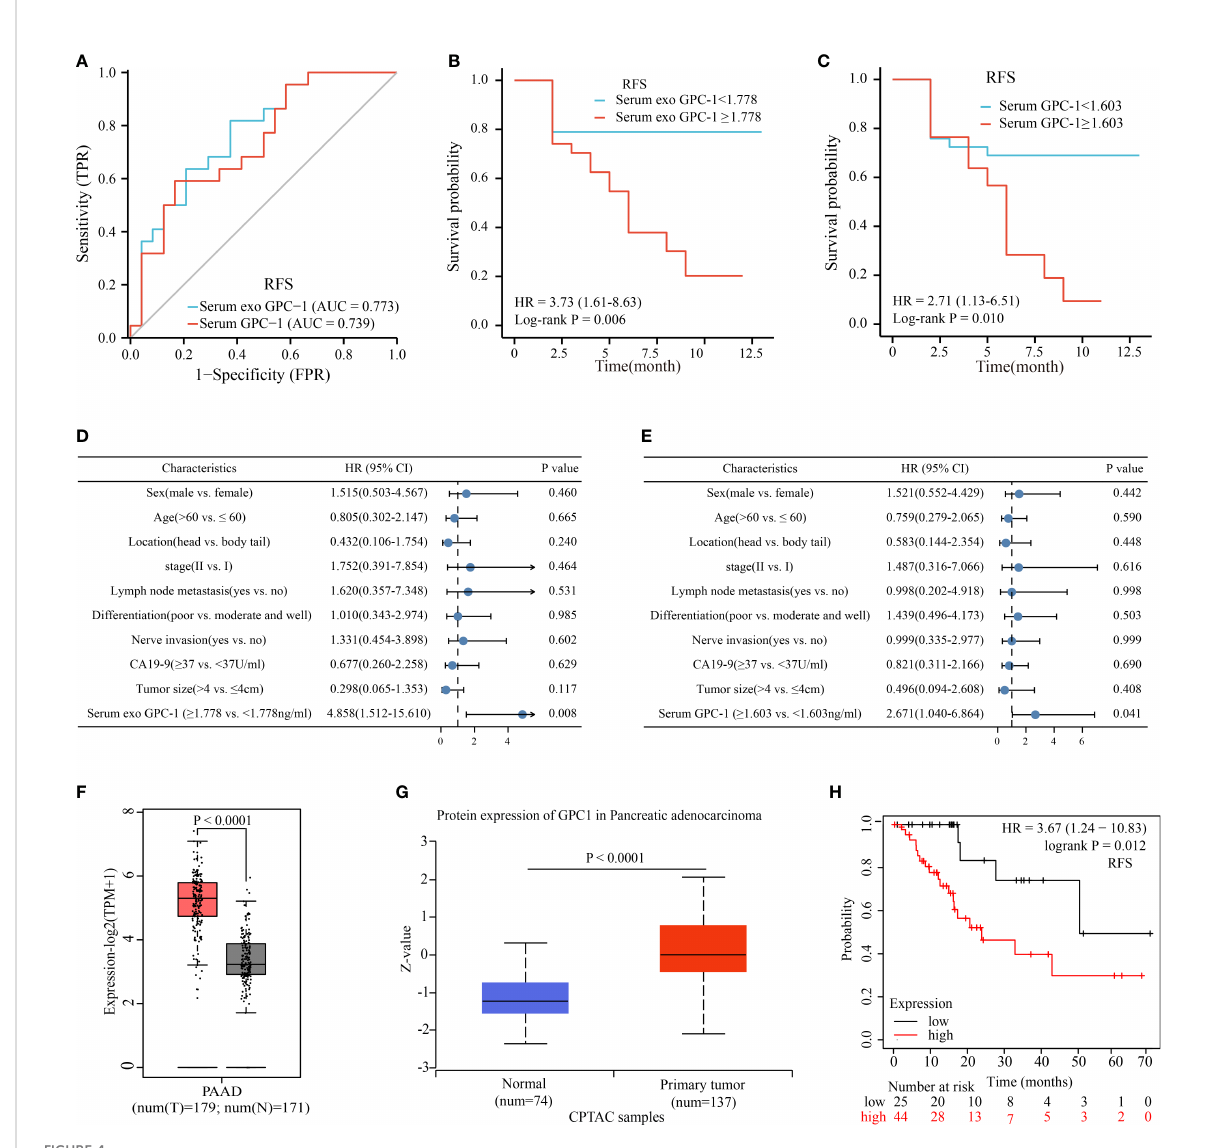
FIGURE 4 GPC-1 was correlated with RFS in patients with PDAC. (A) ROC curve analyses of serum exosomal GPC-1 and serum GPC-1for RFS in early- stage PDAC. Kaplan – Meier curves for RFS according to the optimal cutoff value of serum exosomal GPC-1 (B) and serum exosome GPC-1 (C) in early-stage PDAC patients. Multivariate survival analysis of serum exosomal GPC-1 (D) and serum GPC-1 (E) expression for RFS in patients with PDAC. The mRNA (F) and protein (G) expression levels of GPC-1 were signi fi cantly increased in cancer tissues. (H) Kaplan – Meier curves for RFS according to the expression of GPC-1 in PDAC tissues. PAAD, pancreatic cancer; PDAC, pancreatic ductal carcinoma; ROC, receiver operating characteristic; RFS, relapse-free survival.